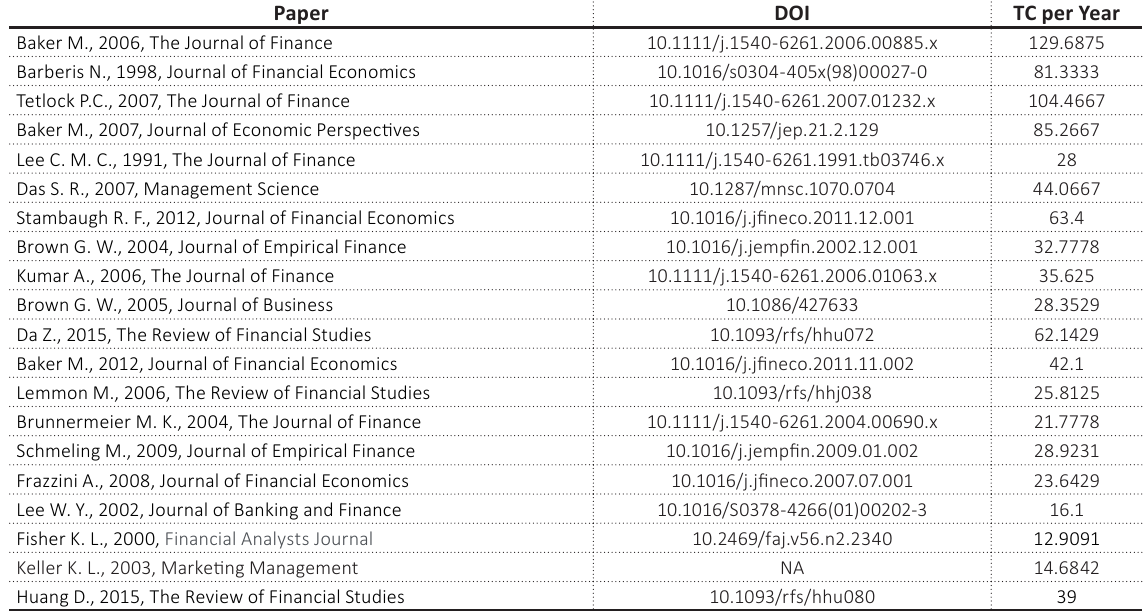
Table 5. Top 20 the most influencing articles